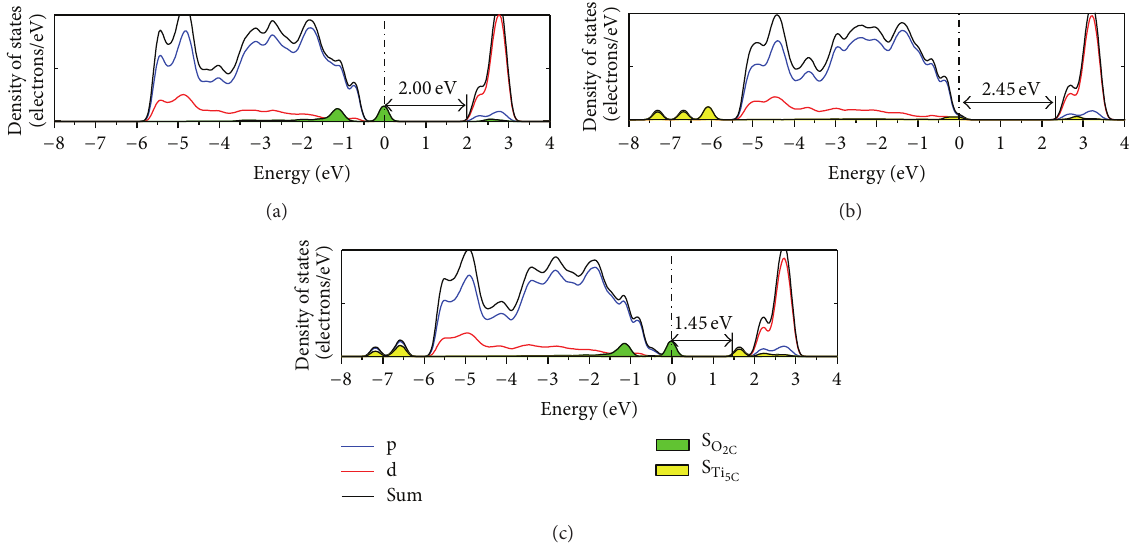
Figure 5: Density of the states (DOS) calculated for S-doped surfaces: (a) Ti 24 O 47 S(A-STO), (b) Ti 23 SO 48 (C-STO), and (c) Ti 23 SO 47 S(AC- STO). Fermi level is at 0 eV and 𝑈 is 8.50 eV for Ti 3d electrons. The 3p states of S dopant at O 2 represented by dark grey and black area, respectively.